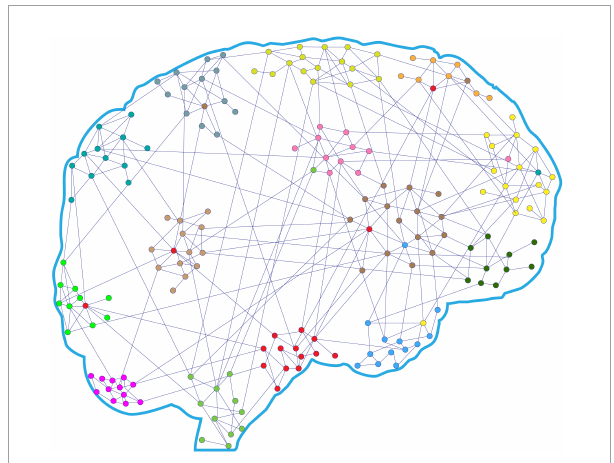
FIGURE2 Schematic representation of the brain’s CAS networks. Brain’s CAS is a complex system consisting of a set of brain areas (nodes; colored points) and a set of pairwise connections between them (edges, ties, or links; lines). A specific set of highly correlated nodes and their ties are called networks, modules, or subsystems. The functions of the brain’s CAS involved in marital behaviors are the result of the local integration of brain areas into segregated modules for specific marital constructs (e.g., positive illusion) and the global integration of modules for directing ultimate marital